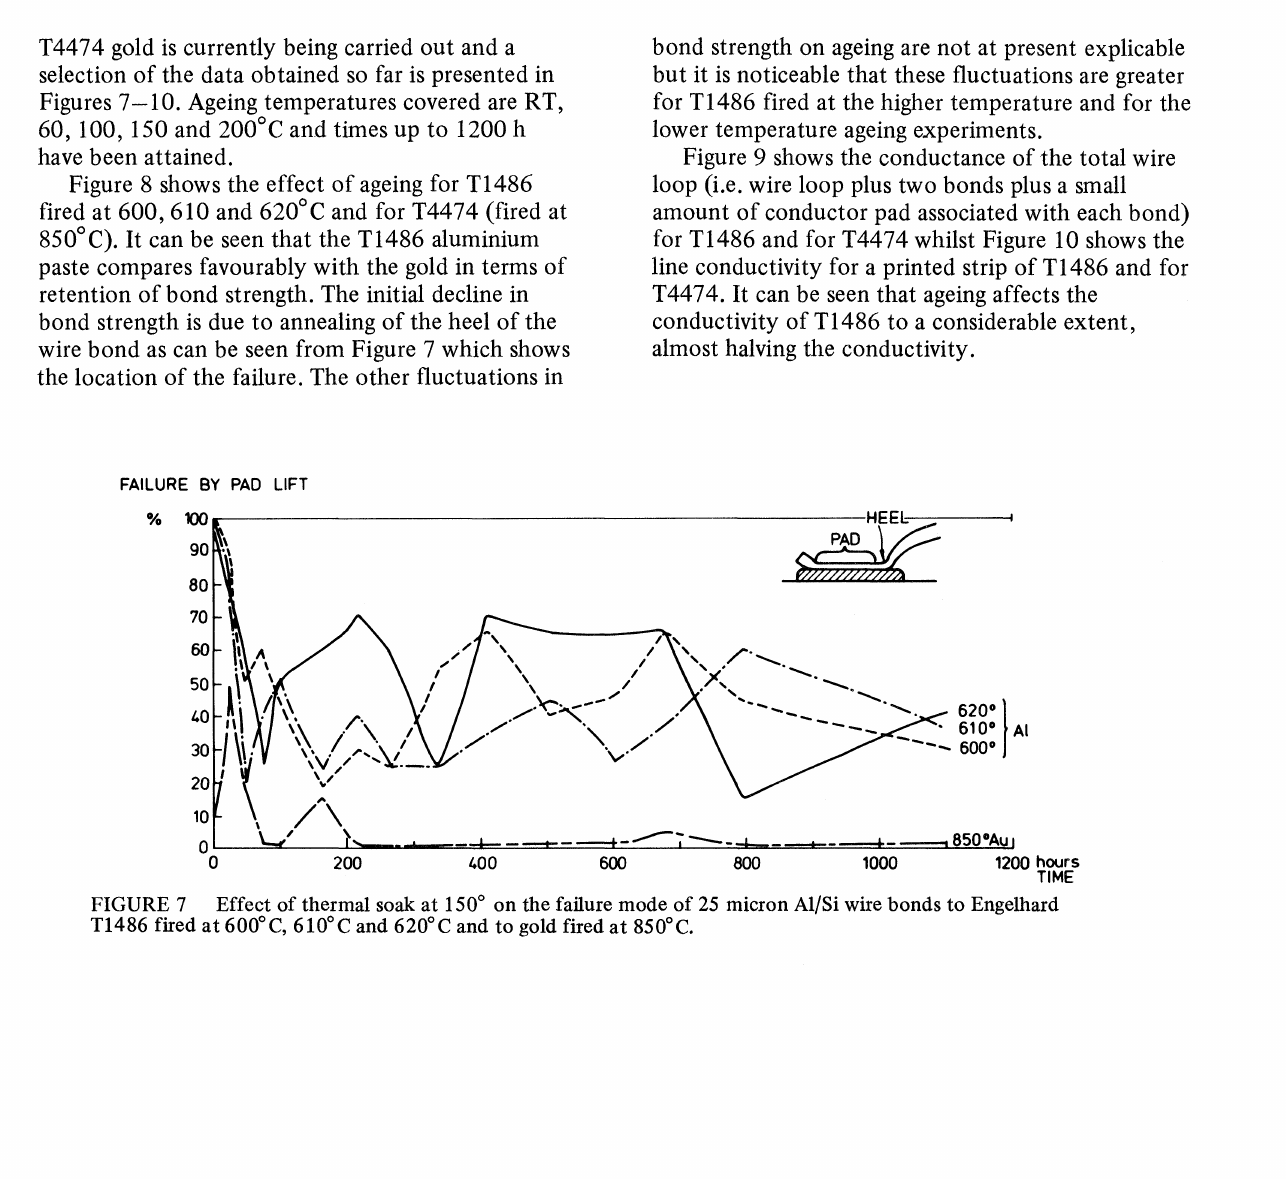
Effect of thermal soak at 150 on the faure mode of 25 micron A1/Si wire bonds to Engelhard T1486 f#ed at 600C, 610C and 620C and to gold fired at